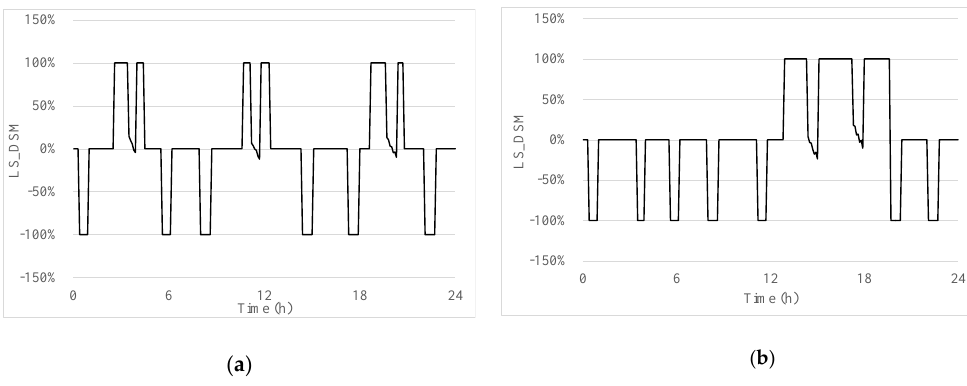
Figure 7. Load shifting indicator ( LS DSM,t ).for the comparison between ( a ) a system with a 300 L vs. 100 L TES and ( b ) a system with 1000 L vs. 100 L TES.